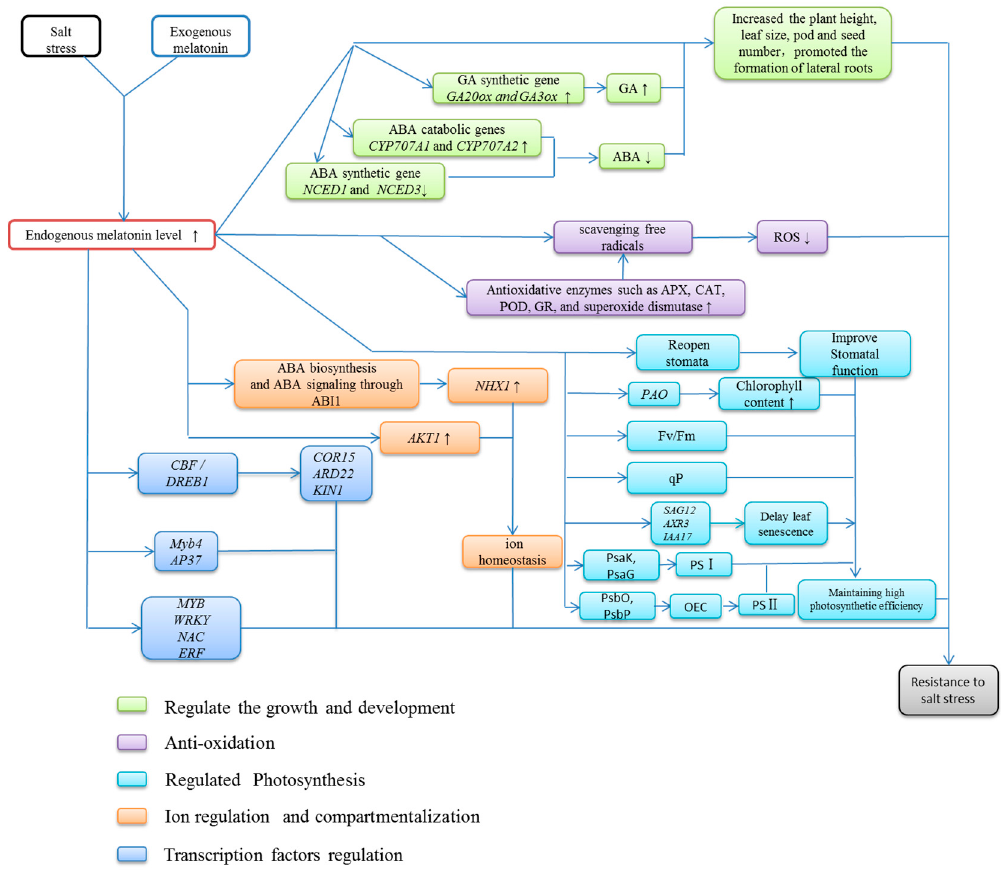
Figure 2. Overview of plant stress responses to exogenous melatonin treatment under salt stress. Melatonin promotes plant growth, regulates photosynthesis, maintains ion homeostasis, and alters the expression of stress-related genes. Different colored boxes represent different effects of melatonin on plant stress response under salt stress. ↑ represents promotion; ↓ represents suppression. ABA: